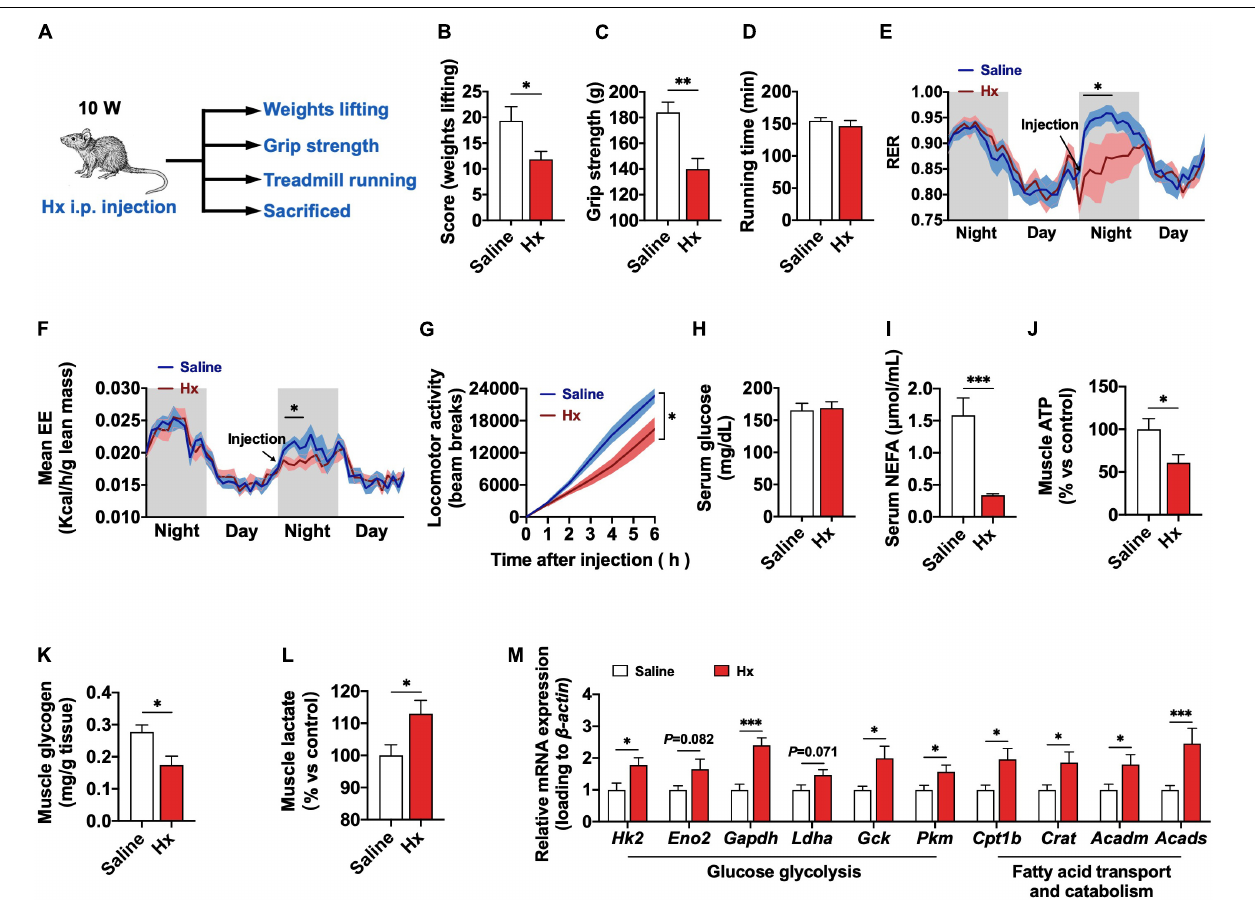
FIGURE 4 | Acute effects of Hx on the exercise capacity and metabolism of mice. (A) Experimental scheme for the acute Hx treatment of mice. (B) Weights lifting score after acute Hx treatment ( n = 8 mice per group). (C) Grip strength after acute Hx treatment ( n = 8 mice per group). (D) Treadmill running time after acute Hx treatment ( n = 8 mice per group). (E,F) RER and EE of mice. The arrow pointed to the time of acute i.p. injection. Gray area indicated dark period ( n = 8 mice per group). (G) Accumulated locomotor activity (bean breaks) of mice after acute Hx treatment ( n = 8 mice per group). (H–L) Serum glucose (H) and NEFA (I) levels; GAS muscle ATP (J) , glycogen (K) , and lactate (L) content of mice after acute Hx treatment ( n = 7–8 mice per group). (M) mRNA expression of genes related to the glucose glycolysis and fatty acid transport and catabolism of GAS muscle after acute Hx treatment ( n = 7–8 mice per group). β -actin was used as loading control in the qRT-PCR. Values are presented as means ± SEM; ∗ P ≤ 0.05, ∗∗ P ≤ 0.01, and ∗∗∗ P ≤ 0.001 according to the non-paired Student’s t -test between individual